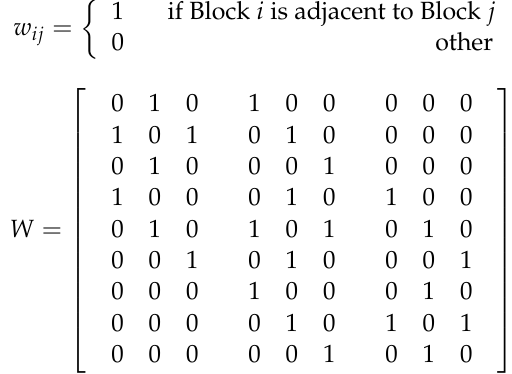
Figure 1. ( a ) is the satellite image with full channel information, and ( b ) is the synthesized RGB image. ( c ) is cut into nine equally sized blocks based on ( b ).